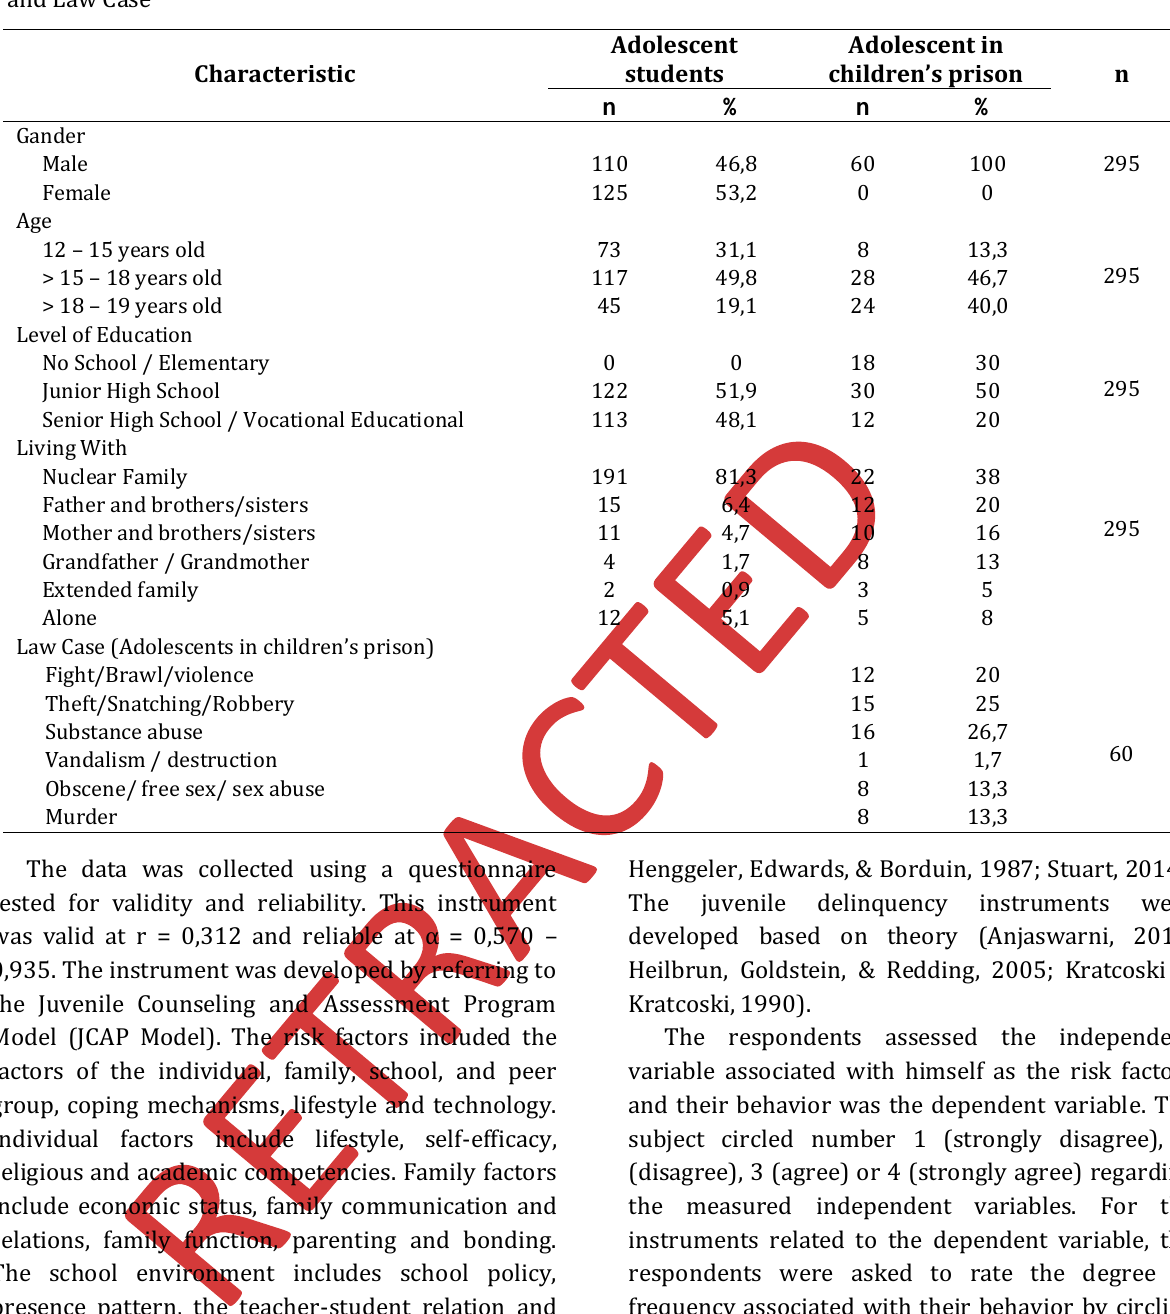
Table 1. Distribution of Respondent’s Characteristic Based on Gender, Age, Level of Education, Living With, and Law